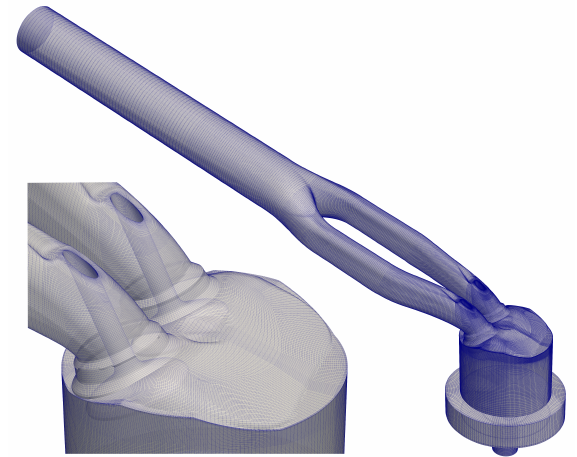
Figure 2. Computational domain with fully hex-hedral grid examplarily showing the coarse mesh with ≈ 4.9 millions CVs (control volumes). Note that the fine mesh amount ≈ 39 millions